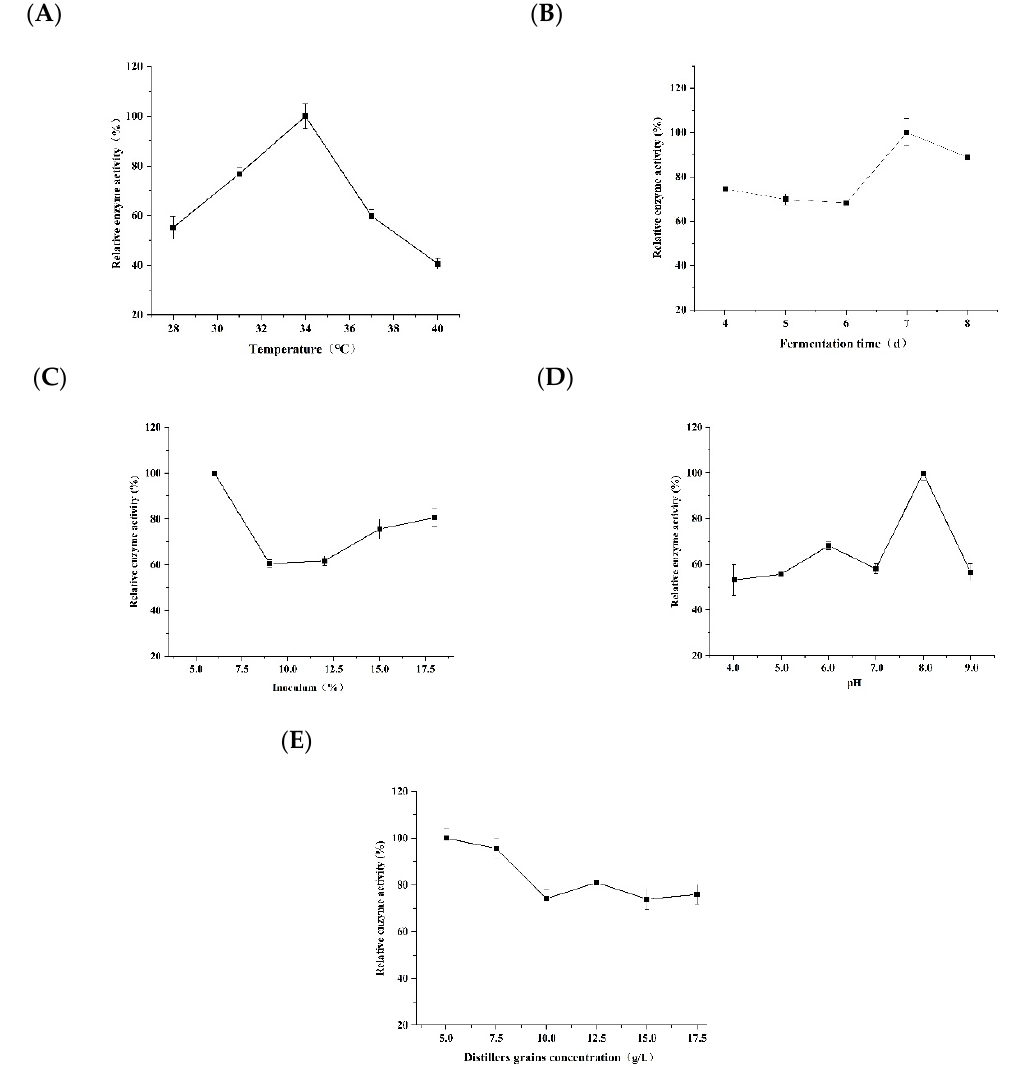
Figure 3. Changes of FAE enzyme activities of microbial combinations under different factors: ( A ) Change laws of FAE enzyme activities of microbial combinations at different temperatures; ( B ) Change laws of FAE enzyme activities of microbial combinations at different fermentation times; ( C ) Different inoculations. The change rule of FAE enzyme activity of the microbial combination under different pH; ( D ) The change rule of FAE enzyme activity of the microbial combination under different distillers grains concentration( E ).